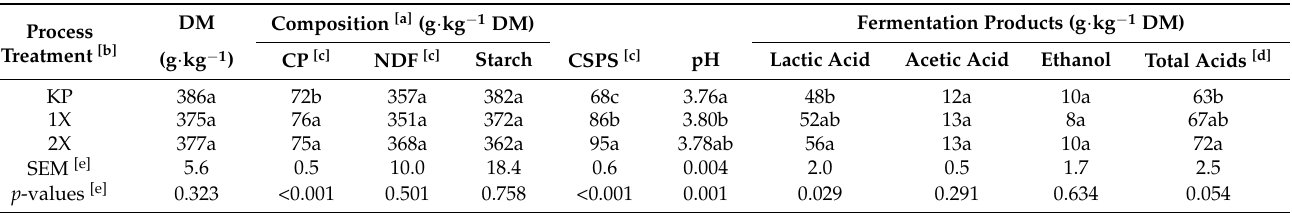
Table 7. Composition and fermentation products of whole-plant corn silage processed with three treatments. Processing took place prior to